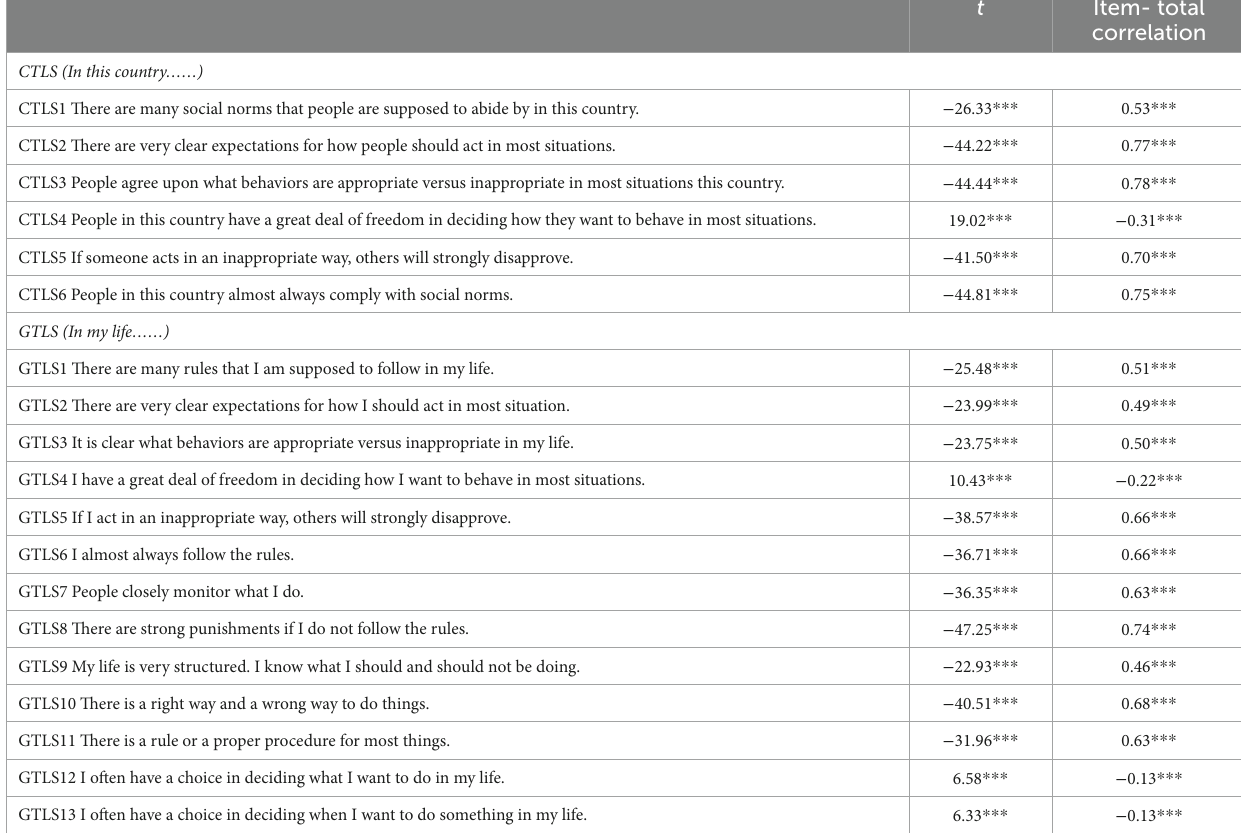
TABLE 1 t -text and item-total correlation ( N =